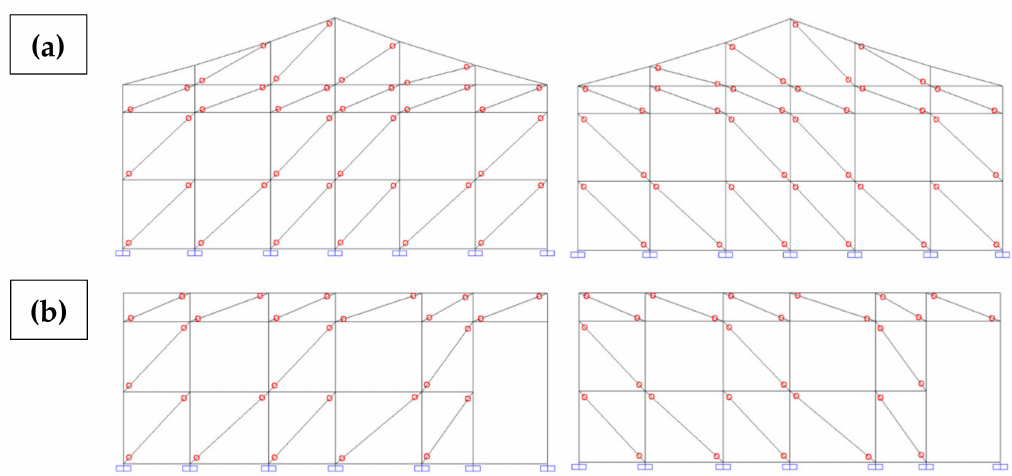
Figure 16. Options for compressed diagonal bars. ( a ) Lateral facade; ( b ) Front facade [34]. Diagonal bars were characterized according to experimental data obtained for the elastic modulus.